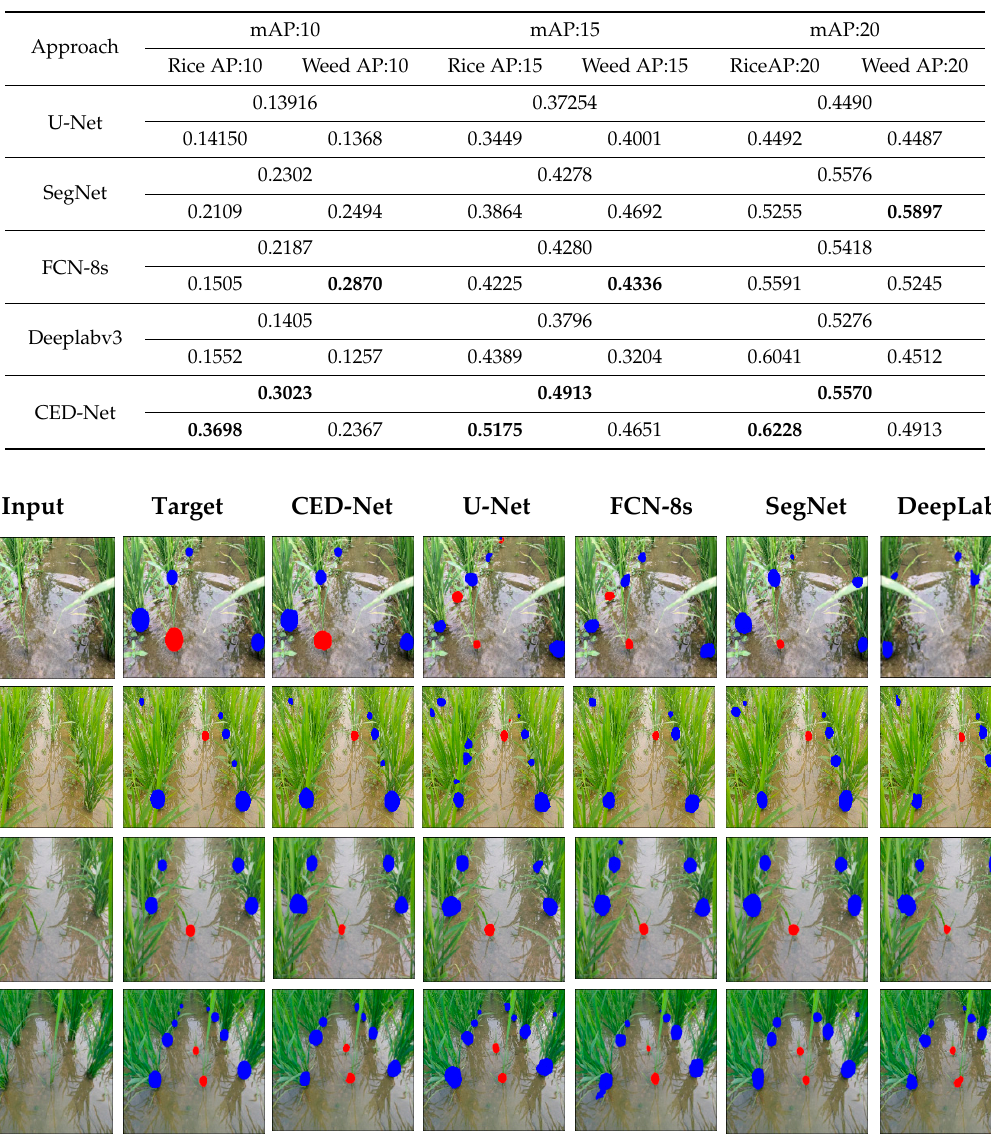
Figure 7. Experimental results of the paddy-millet dataset. Table 10. Results using average precision (AP) and mean average precision (mAP) variants, the number next to the AP/mAP represents different threshold levels (bold number represents the best results in the table).